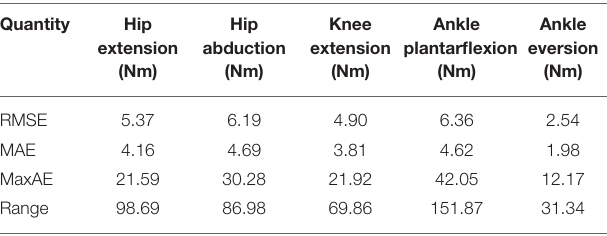
TABLE 3 | Root-mean-square error (RMSE), mean absolute error (MAE), maximum absolute error (MaxAE), and range in joint moments over the gait cycle from muscle-tendon model